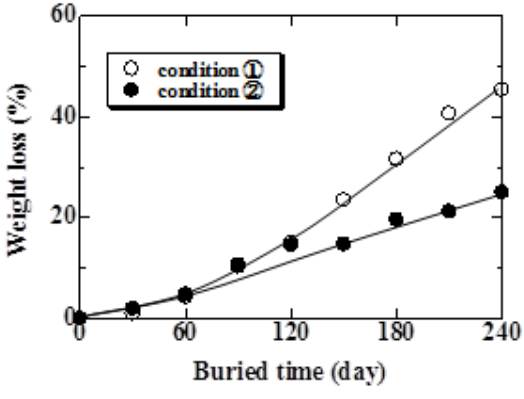
Figure 10. Relationship between weight loss and composting time under Conditions 3 and